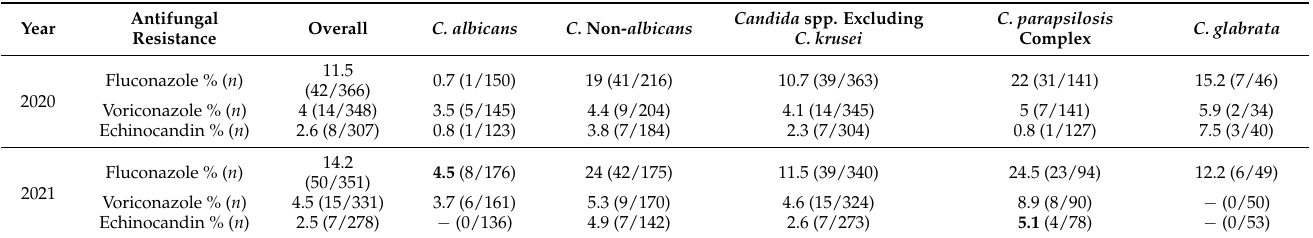
Table 4. Comparison per year of azole and echinocandin resistance in Candida species isolates tested in the